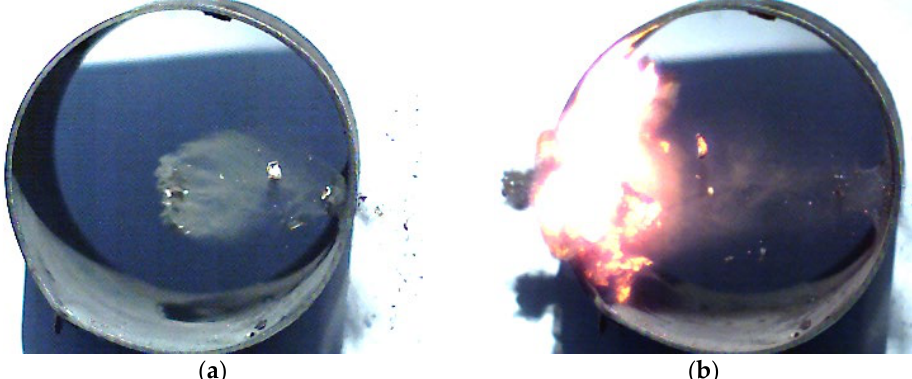
Figure 6. Shooting through the cylinder’s cutouts: ( a ) shell puncture; ( b ) burnout of powder particles.